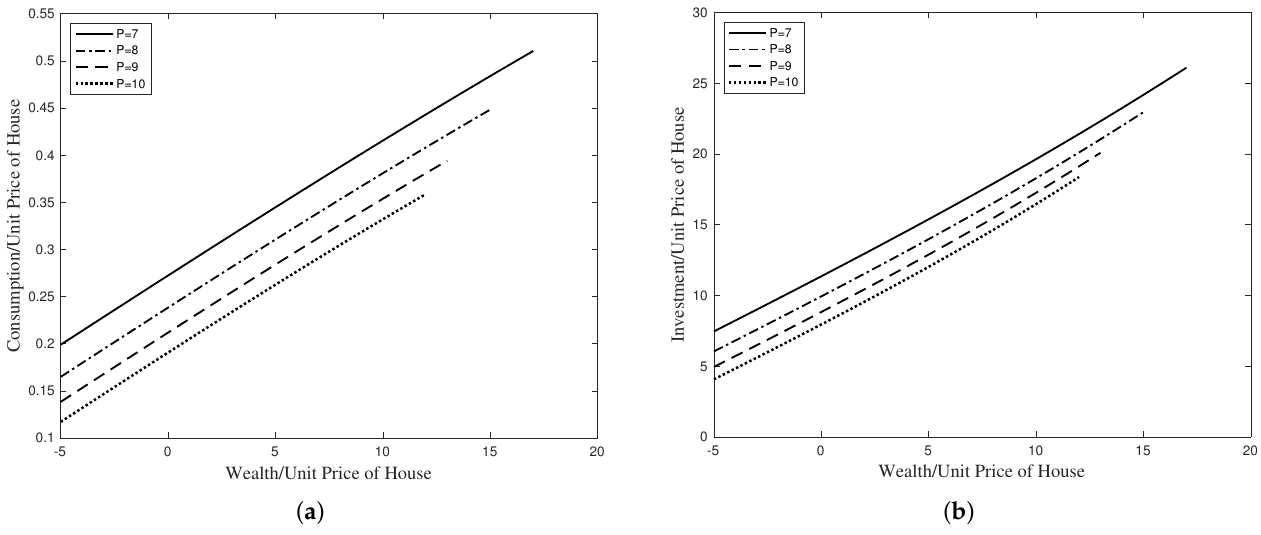
Figure 6. Optimal consumption and investment policies with changes in housing price. ( a ) Consump- tion. ( b )